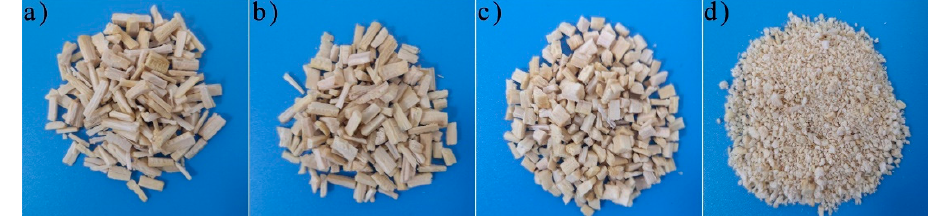
Figure 1. The shape of 10 mm ( a ), 7 mm ( b ), 4 mm ( c ) miscanthus lutarioriparius (ML) strips and ML powders ( d ).